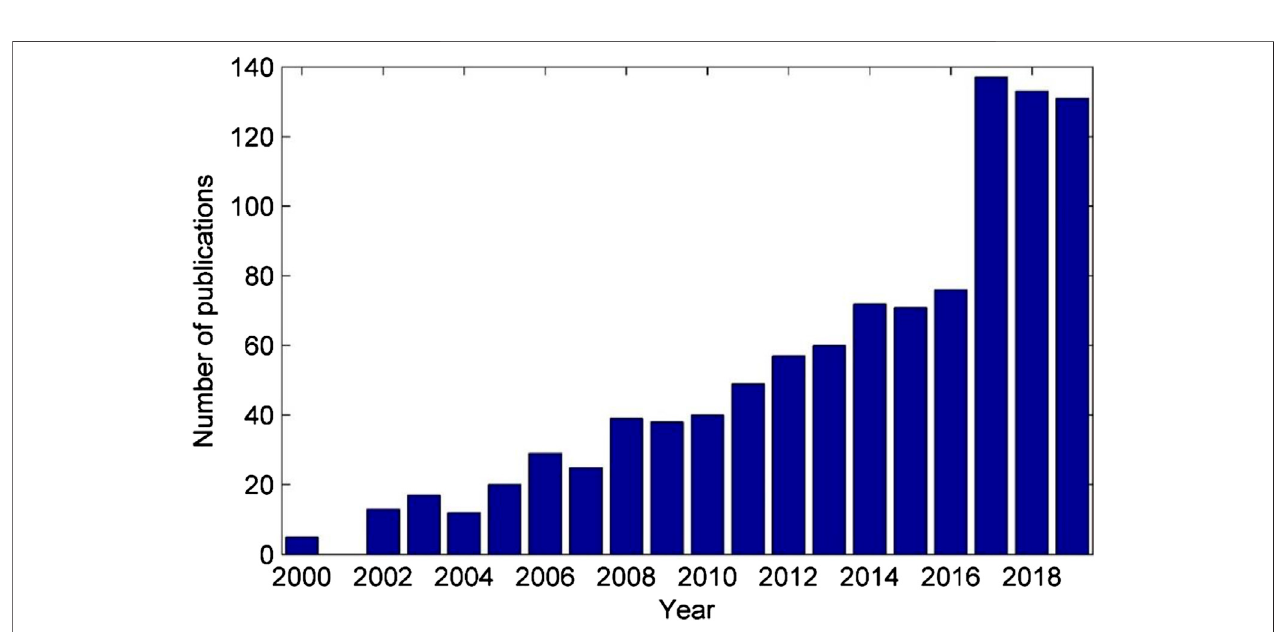
FIGURE 2 | Number of publications (2000 – 2019) listed in the Web of Science database for the terms “ permafrost hydrology ” or “ frozen soil hydrology ” or “ permafrost water ” or “ frozen soil water ” at “ Xizang ” or “ Tibet ” or “ Qinghai ” or “ Heihe ” or “ Hei River. ”